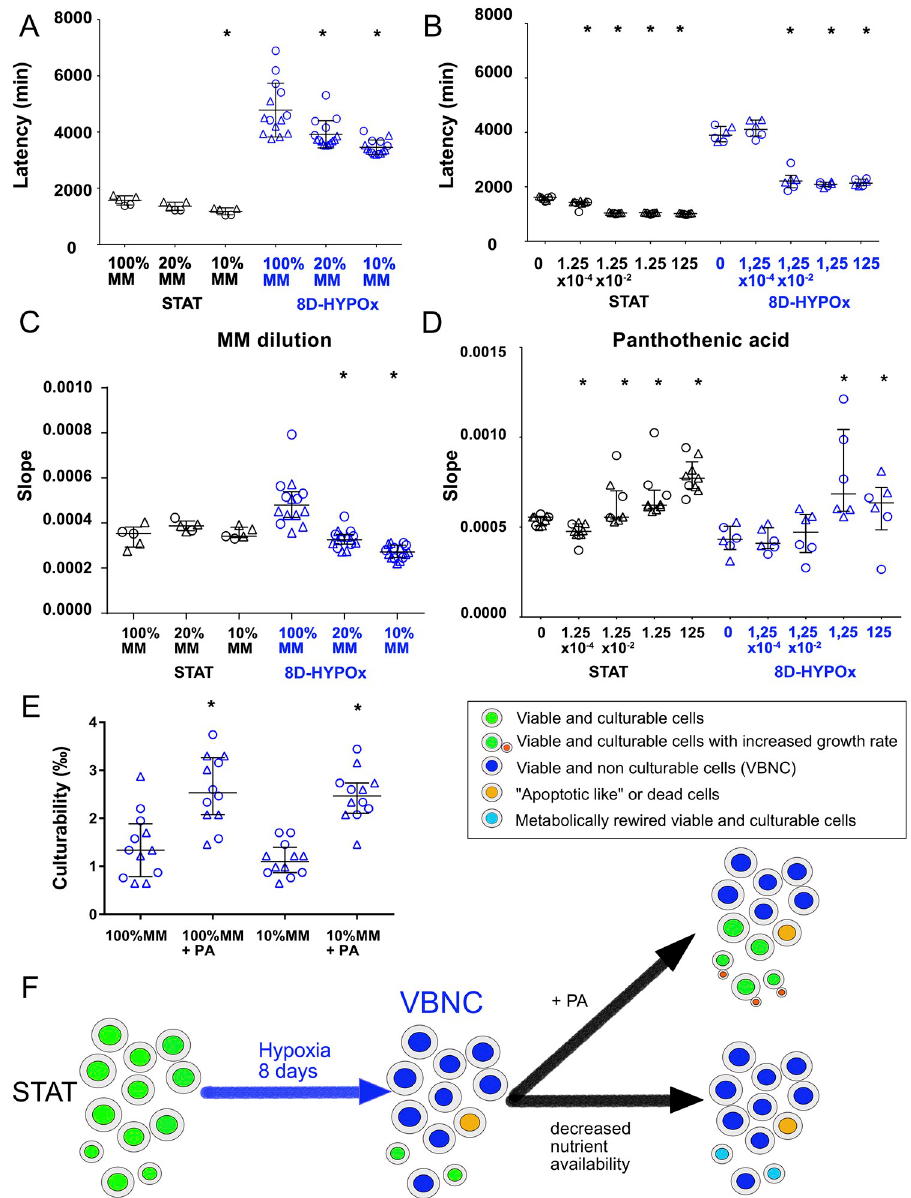
Fig 3. Cryptococcus neoformans incubated for 8 days in hypoxia reactivated with pantothenic acid (PA) and culturable cells rewired in minimal medium (MM) dilutions. Growth curves were determined on yeasts recovered as STAT or 8D-HYPOx and then refed in diluted MM. Latency and growth rate (slope) were then determined. Experiments were all repeated twice (independent experiments are identified as circle or triangle). Graph includes dot for the replicates, as well as median ± IQR ( � p < 0.01 compared to control in the same condition). A . The dilution of minimal medium from 100% to 10% (diluted MM) resulted in a progressive decrease of latency in 8D-HYPOx cells and to a lesser extend in STAT cells. ( � p < 0.01 compared to 100%MM). Two independent experiments were pooled. Each point represents the latency/well in two (STAT n = 5, 8D-HYPOx n = 15) B . 100-fold dilution of pantothenic acid (starting at 125 μ M) were added to the suspension prior to growth curve determination. Pantothenic acid significantly decreased the latency at a concentration of 1.25x10 -2 μ M or more in 8D-HYPOx and to a lesser extend in STAT cells ( � p < 0.01). Two independent experiments were pooled. Each point represents the latency/well in two (STAT n = 9, 8D-HYPOx n = 6). C . Growth rate was significantly decreased in 20%MM and 10%MM in 8D-HYPOx D . A significantly increased growth rate was observed after addition of PA (1.25 μ M or more) to 8D-HYPOx cells and at all concentrations for STAT. E . The addition of pantothenic acid at 125 μ M but not the dilution of MM increased the culturability of 8D-HYPOx based on the observation of the number of positive wells (100 cells per well) and